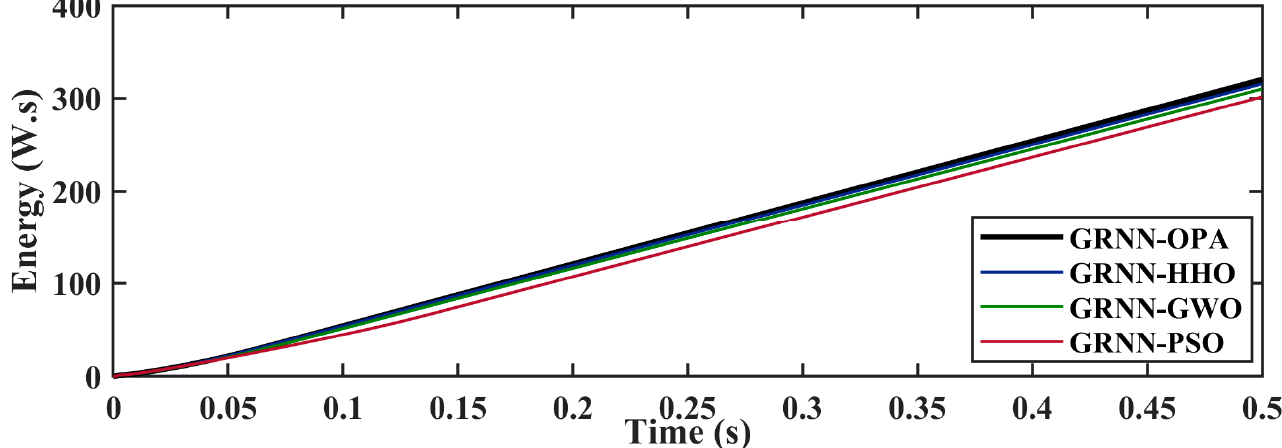
Figure 9. Comparison of energy extracted in case 1.